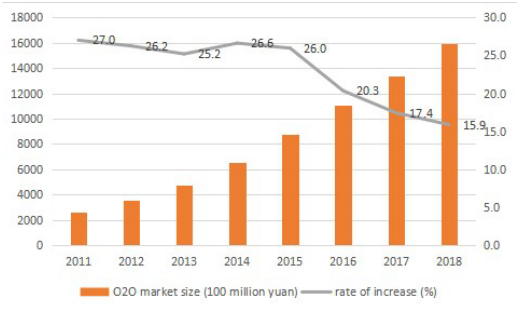
Figure 3. o2o market analysis in China Chef of the door to door service o2o ends of supply and demand is not balanced, for example, when dinner need a chef of the door to door service, often need a lot of chef. This is often hotel is the most busy time, cooks very difficult to go to do a part-time job. This makes no sufficient number of chefs to meet user demand, resulting in both supply and demand is out of balance. From the concrete operational level, the chef also need equipment and tools, part of the hotel chef is not suitable for in home to do the ordinary food. Chef of the door to door service o2o another obstacle is, meal also belongs to non standardized products, for